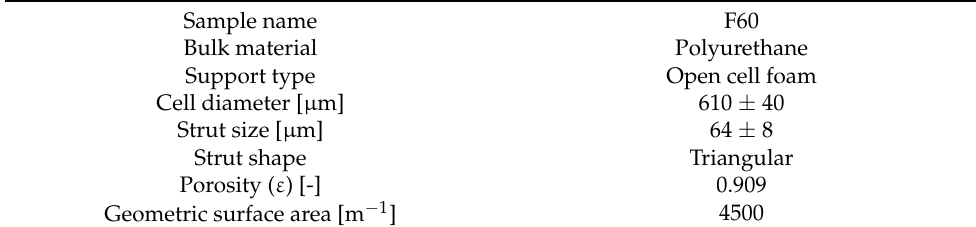
Table 1. Resume of the geometrical properties of the commercial polyurethane open cell foams (F). The number in the sample label indicates the